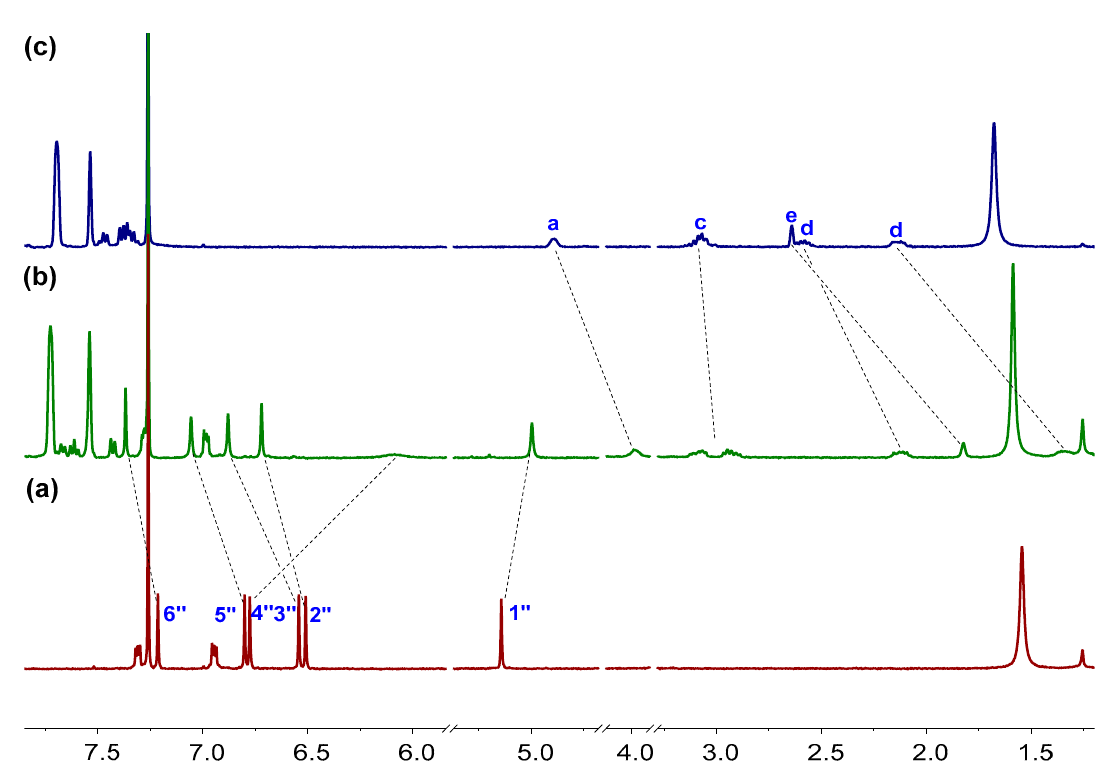
Figure 6. Partial 1 H NMR spectra (500 MHz, 298 K, CDCl 3 ) of ( a ) M - H , ( b ) M - H + 1.0 equiv. S - G1 , ( c ) S - G1 . [ M - H ] 0 = 3.0 mM.